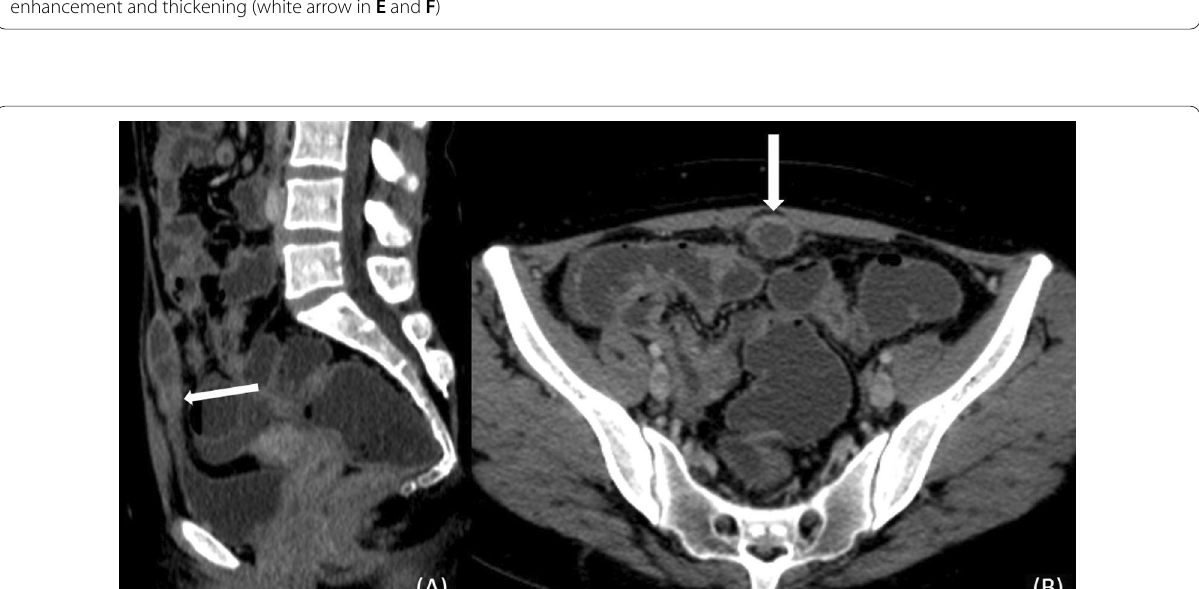
Fig. 12 Tuberculosis of the urachal cyst. CT images of a 26-year-old female show irregular thickening and enhancement of urachal cyst wall (white arrow in A and B